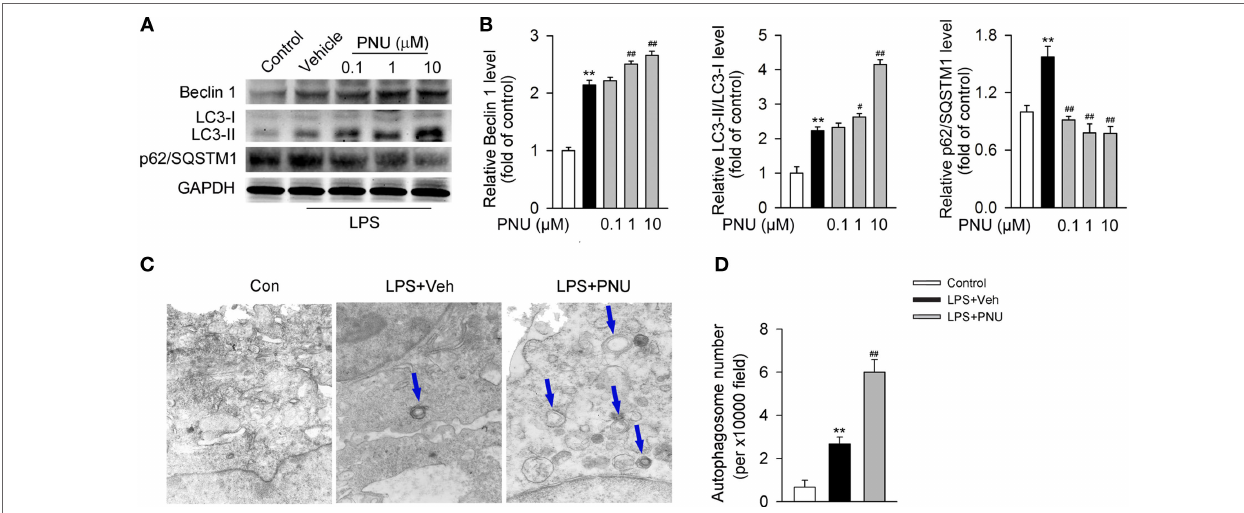
FigUre 5 | α 7nachr activation leads to the enhancement of autophagy in BV2 microglia stimulated with lipopolysaccharide (lPs) . (a) BV2 microglia were pretreated with vehicle or PNU282987 in three different doses (0.1, 1, and 10 µM) and then challenged with LPS (100 ng/ml). Relative expressions of autophagy-related proteins were detected by Western blotting. PNU282987 significantly enhanced the levels of Beclin 1 and LC3-II/I ratio and reduced the expression of p62/SQSTM1 compared with vehicle ( n = 6 per group). (B) Quantitative analysis of relative levels of Beclin 1, LC3-II/I ratio, and p62/SQSTM1. ** P < 0.01 vs normal, # P < 0.05 vs Veh, ## P < 0.01 vs Veh. (c) BV2 microglia were pretreated with vehicle or PNU282987 (10 µM) and then challenged with LPS (100 ng/ml). The number of autophagosomes was detected by transmission electron microscopy and autophagosomes were marked by blue arrows. PNU282987 significantly increased the number of autophagosomes compared with vehicle ( n = 6 per group). Magnification, 10,000 × . (D) Quantitative analysis of the number of autophagosomes in BV2 microglia. ** P < 0.01 vs normal, ## P < 0.01 vs Veh. Veh, vehicle; PNU, PNU282987.